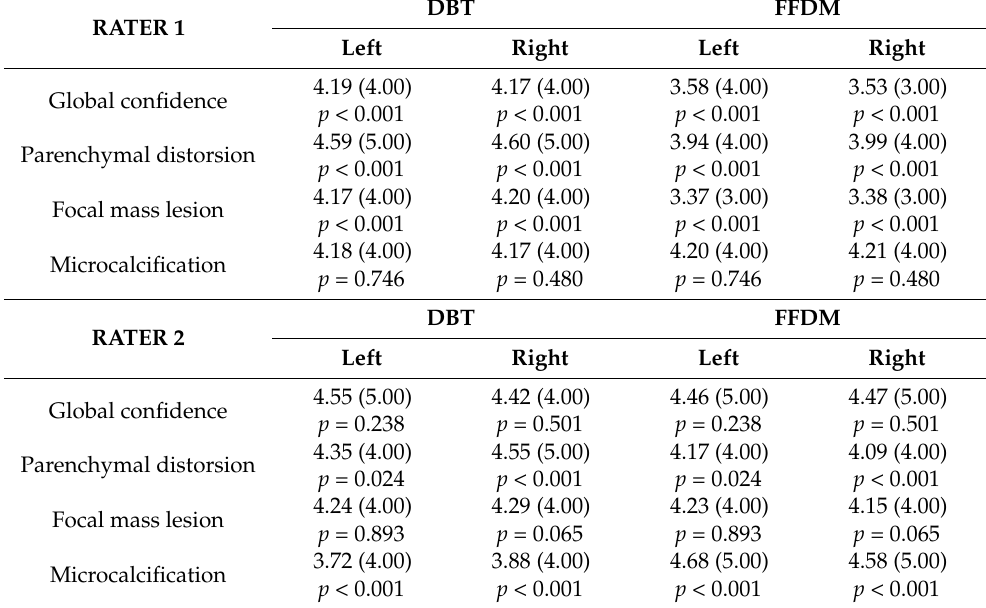
Table 3. Determination of image quality of digital breast tomosynthesis (DBT) and full-field digital mammography (FFDM) (mean; median values in parentheses; p -values of Wilcoxon signed rank test analysing difference between DBT and FFDM) by two independent raters for the following